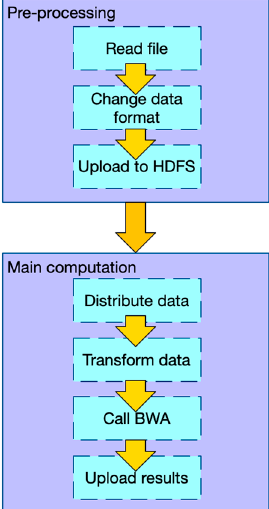
Figure 1. The workflow of PipeMEM in the paired-end situation. In the pre-processing stage, two input fastq files are merged and transformed, and then uploaded to HDFS (Hadoop Distributed File System). In the main computation stage, the merged file is distributed to computing nodes by Spark API (Application Programming Interfaces). In local-node, PipeMEM would redo the modification, then evoke BWA-MEM to process these data. After that, PipeMEM would upload these results to HDFS with Spark API.